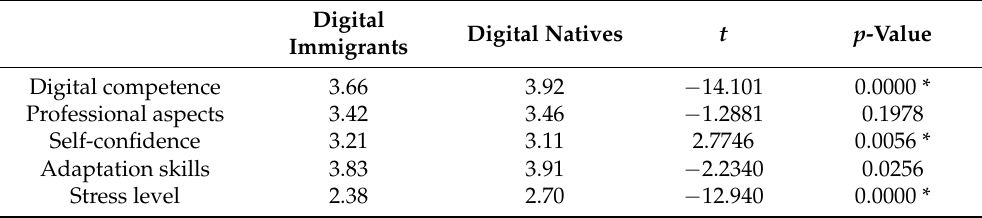
Table 8. Mean values of the subscales of the survey and statistics of the t -test when differentiating by digital generation (mean values out of five). Digital Digital Natives t p -Value Immigrants Digital competence 3.66 3.92 0.0000 *